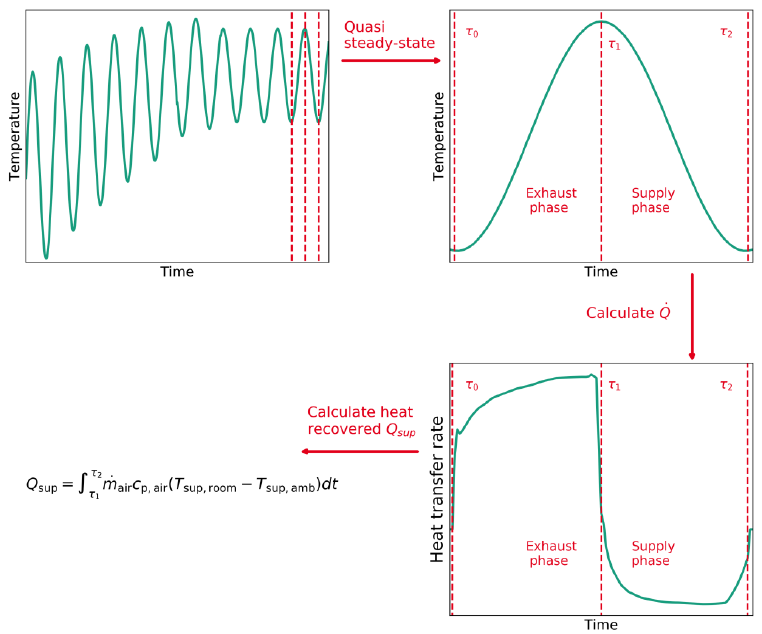
Figure 6. Workflow to calculate the supply heat recovered.